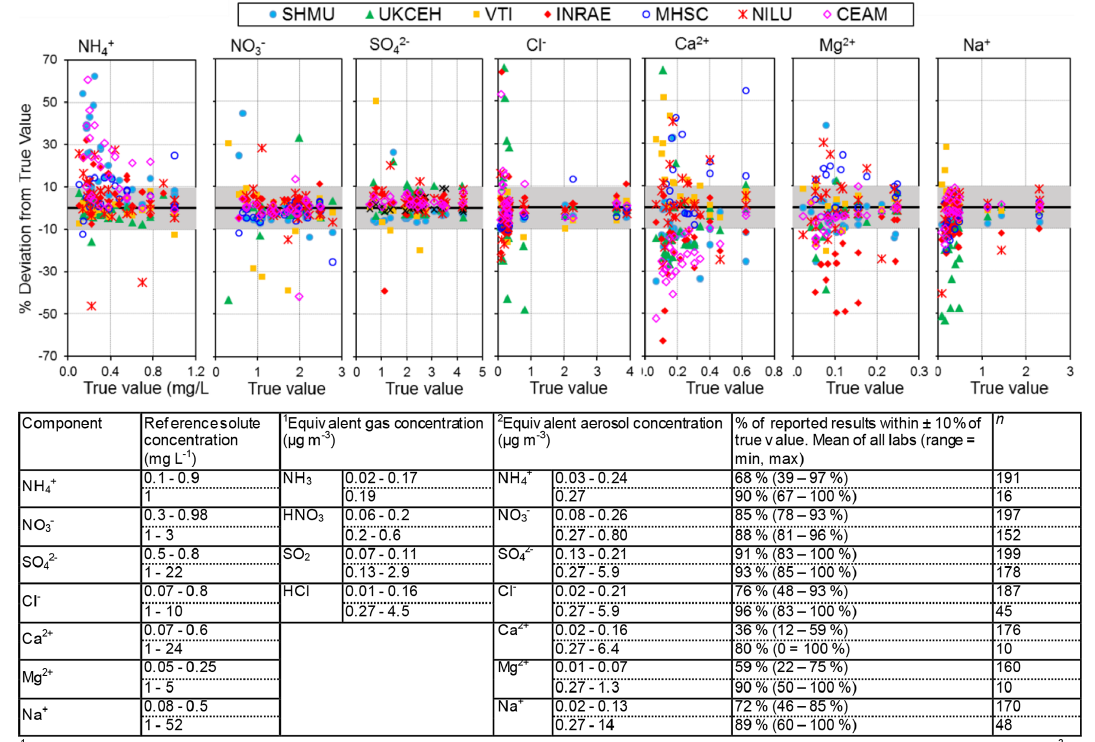
Figure 4. Summary of reported results from all laboratories in chemistry proficiency testing (PT) schemes for chemical analysis of aqueous inorganic ions (2006–2010: EMEP, WMO-GAW, and NitroEurope), expressed as a percentage deviation from the true value (PT reference solutions). The grey shaded areas in the graphs show values that are within ± 10% of true